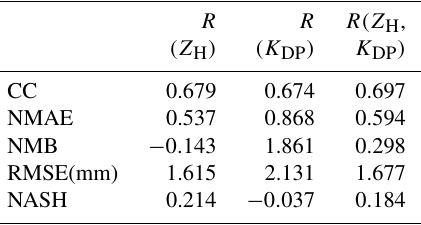
Table 3. Verification of the radar-based rainfall 1h accumulation products of Estonia. Z H is not corrected for attenuation.